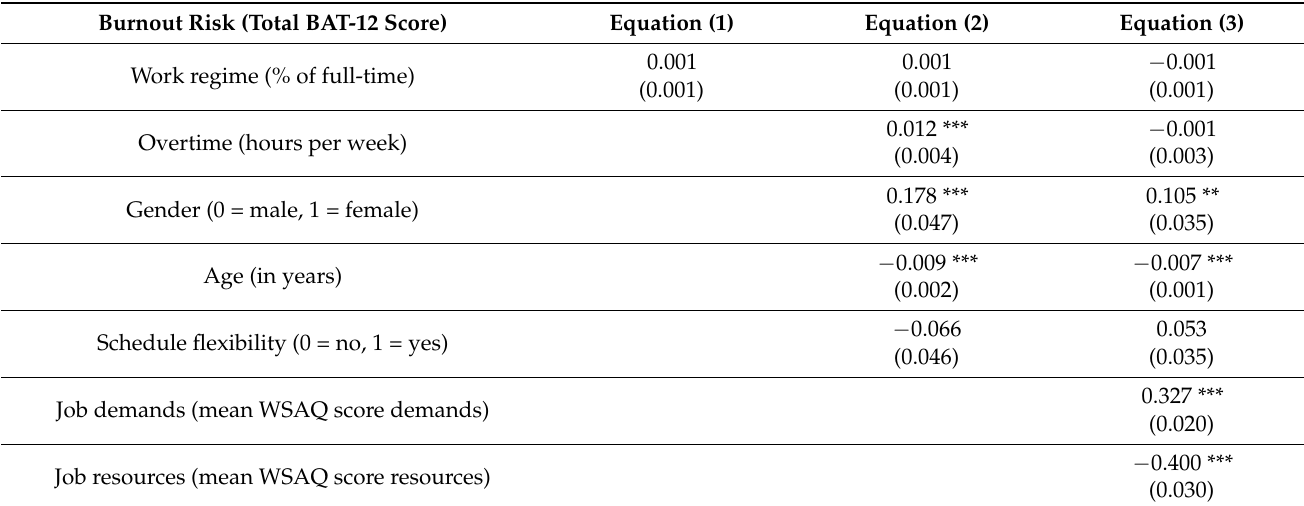
Table 3. Regression analysis of the dependent variable burnout risk on the independent variable work